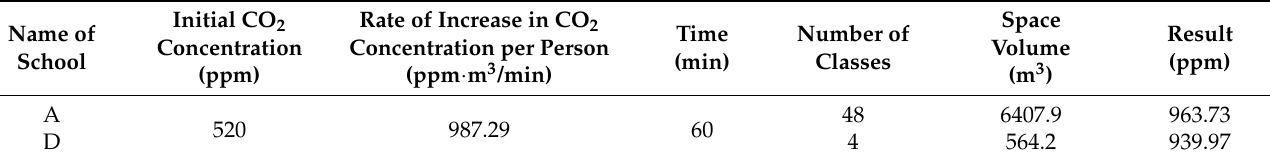
Table 15. CO 2 concentration generated by the optimum number of students in elementary school A and D during badminton activities calculated using Equation